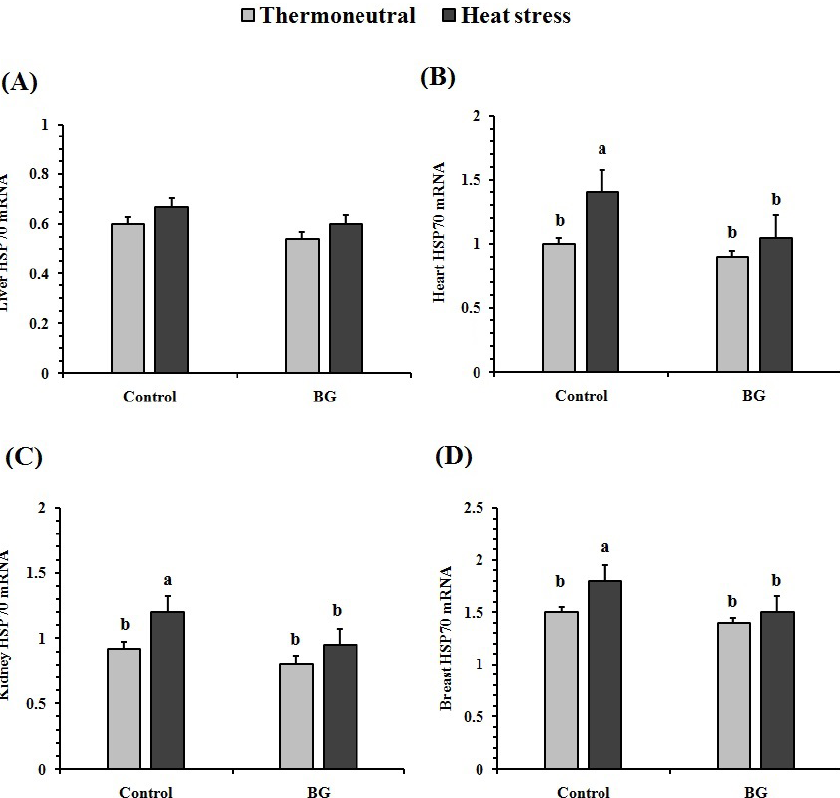
Figure 2. Effect of bee glue (BG) supplementation on gene expression of heat shock protein 70 (HSP70) in liver (a) , heart (b) , kidney (c) , and breast muscle (d) of broilers subjected to heat challenge. Mean values represent the average of six replicates of four groups ( n = 6). Values are means ± SEM. Within the graph, bars with different letters (a–b) are significantly different ( P < 0 .